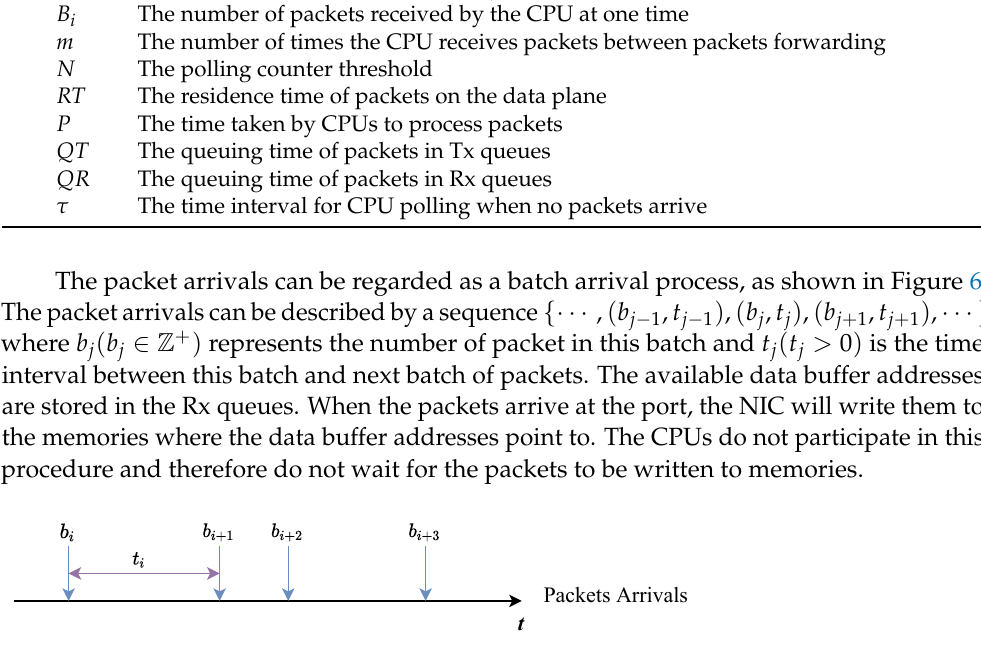
Figure 6. Schematic diagram of packets arrival in